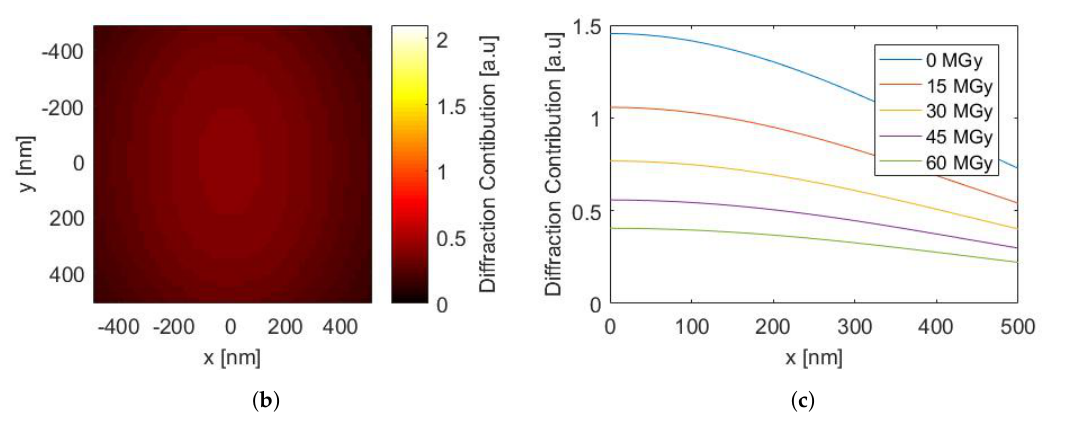
Figure 5. Heat map showing diffraction volume, as a function of global dose, for a 1µm crystal centred in a 12keV, 1µm beam (FWHM). The heat maps show the contribution to diffracted signal of a 2D slice perpendicular to the beam direction, when the crystal has absorbed a global dose of: ( a ) 0MGy; ( b ) 30MGy; and ( c ) 60MGy. Panel ( d ) summarises the drop in diffraction volume along the x -axis (parallel to the polarisation axis of the X-ray beam), including additional calculations after the crystal has absorbed doses of 15MGy and